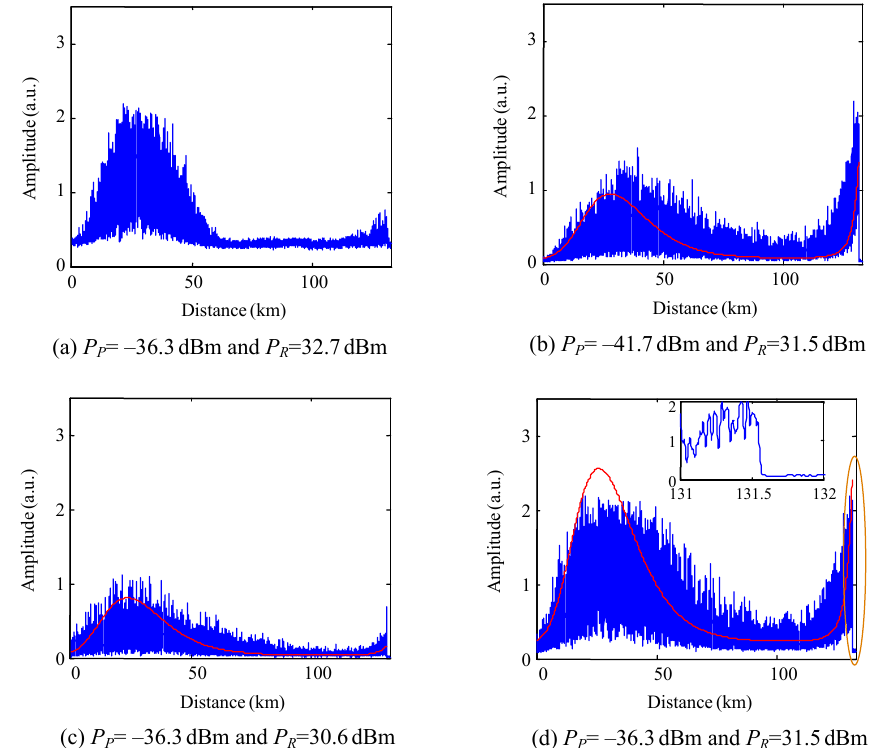
Fig. 4 Rayleigh backscattering signals with different combinations of probe and pump light, where the curves in (b), (c), and (d) are the results of